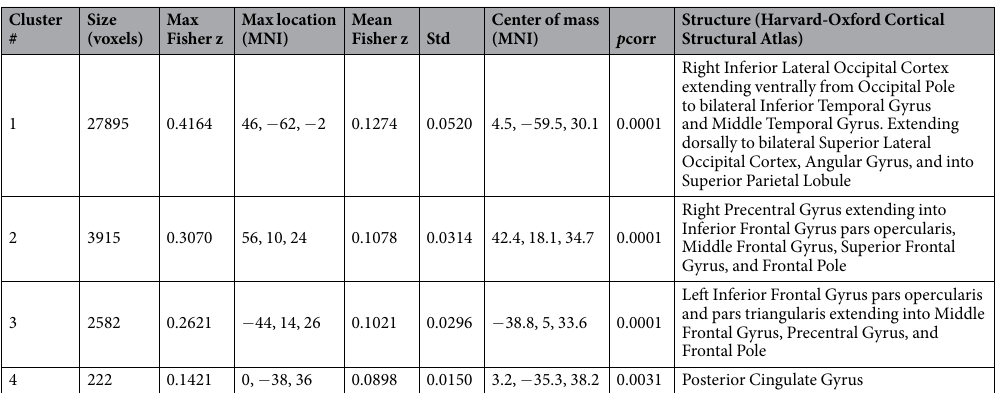
Cluster Size Max Max location # (voxels) Fisher z (MNI)